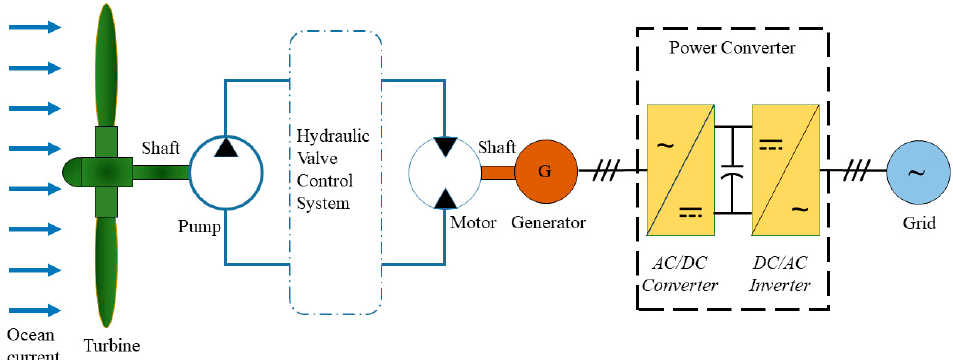
Figure 3. Diagram of an ocean current turbine hydraulic energy generation system.